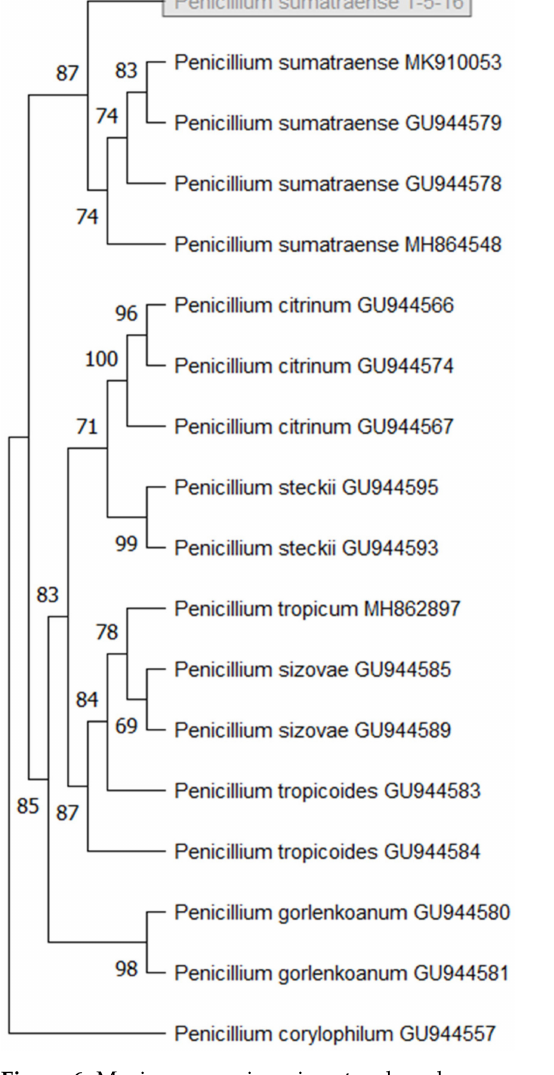
Figure 6. Maximum parsimonious tree based on sequences of rDNA ITS region. Isolated strain SC29 is highlighted in the grey